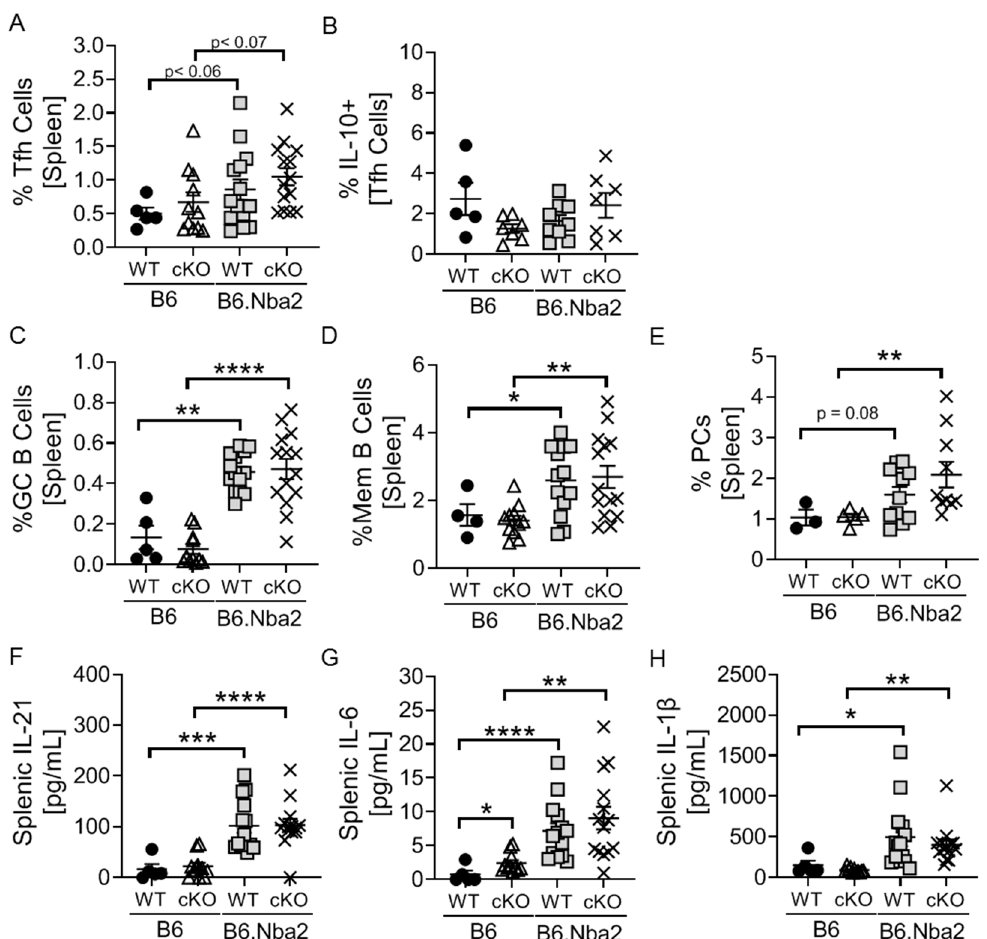
Figure 4. Spontaneous accumulation of Tfh cells, GC B cells, memory B cells and plasma cells is independent of T-cell specific IFNAR expression. IFNAR-sufficient and -deficient female B6 and B6.Nba2 mice were analyzed for splenic frequencies of Tfh cells ( A , B ), GC B cells ( C ) memory B cells ( D ), Plasma cells ( E ) by flow cytometry. ( F – H ) Splenic IL-21, IL-6 and IL-1 β levels were determined by electrochemiluminescence as described in Material and Methods. Each symbol represent one mouse. n = 4–5 (B6), n = 11 (B6 cKO), n = 14 (B6.Nba2), n = 9 (B6.Nba2 cKO). * p < 0.05; ** p < 0.01; *** p < 0.001; **** p < 0.0001, Student’s unpaired t -test with Welch’s correction.